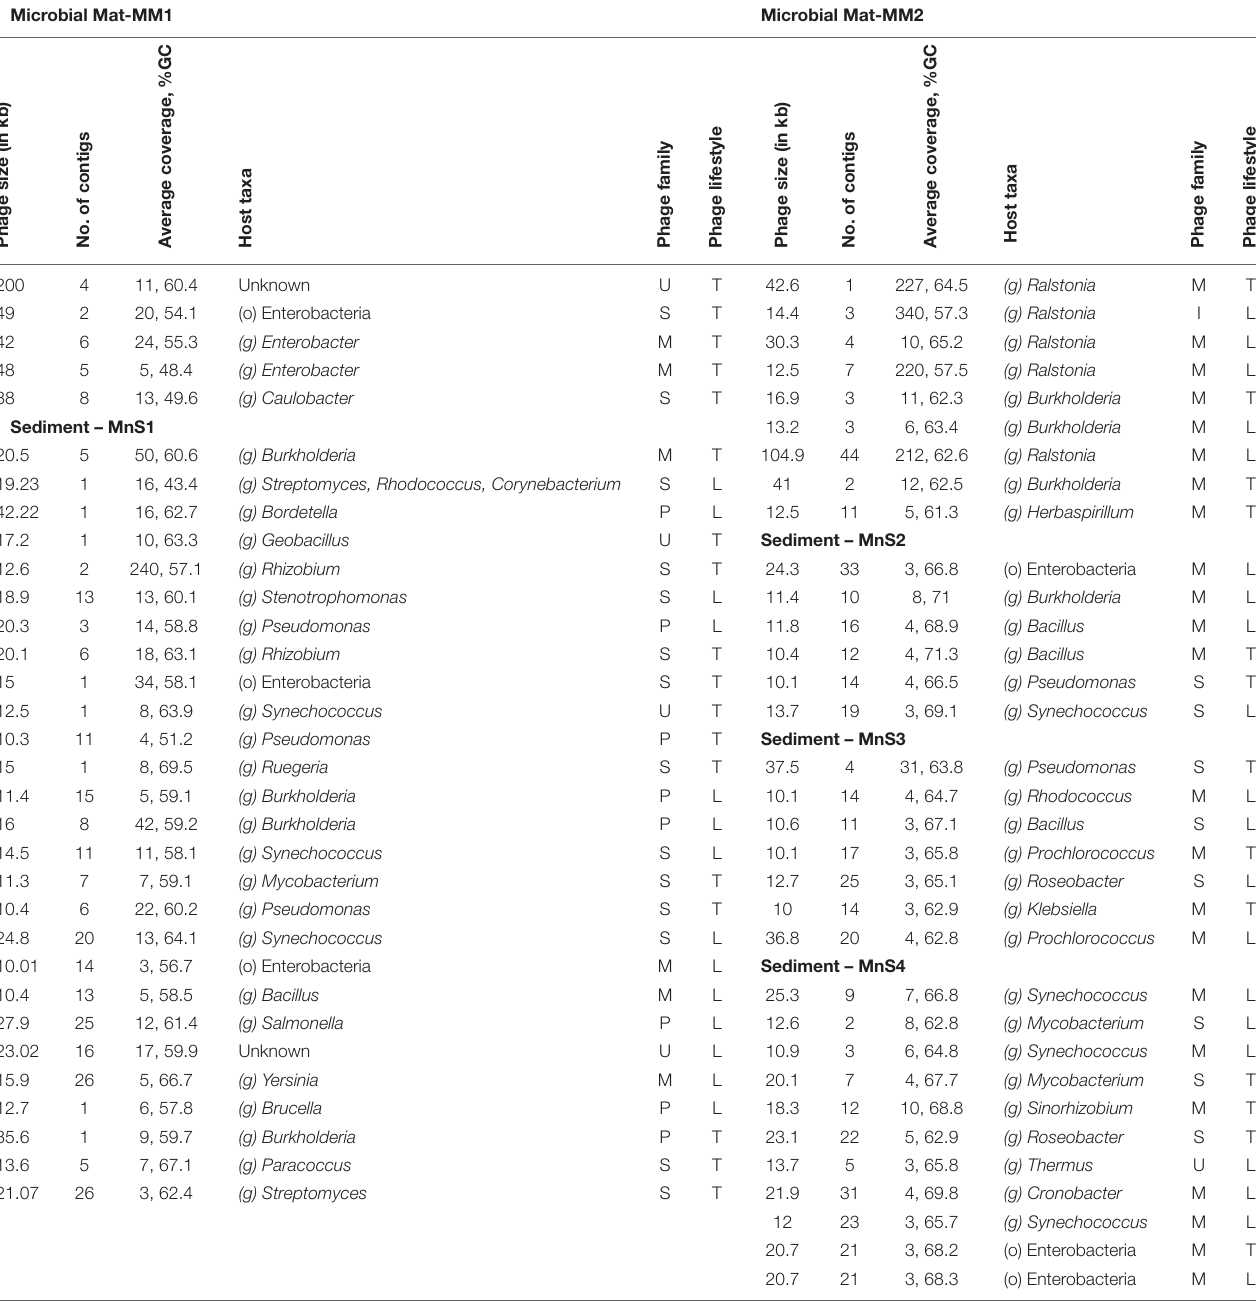
TABLE 2 | Characteristics of phages reconstructed across microbial mat and sediment of Manikaran hot springs. Microbial Mat-MM1 Microbial